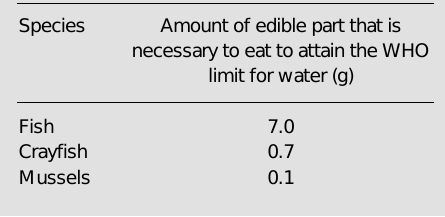
Table 3 - Amount of edible parts of fish, crayfish and mussels contaminated with the levels de- scribed in Table 2 that is necessary to ingest to attain WHO limit values for MCYST in drinking